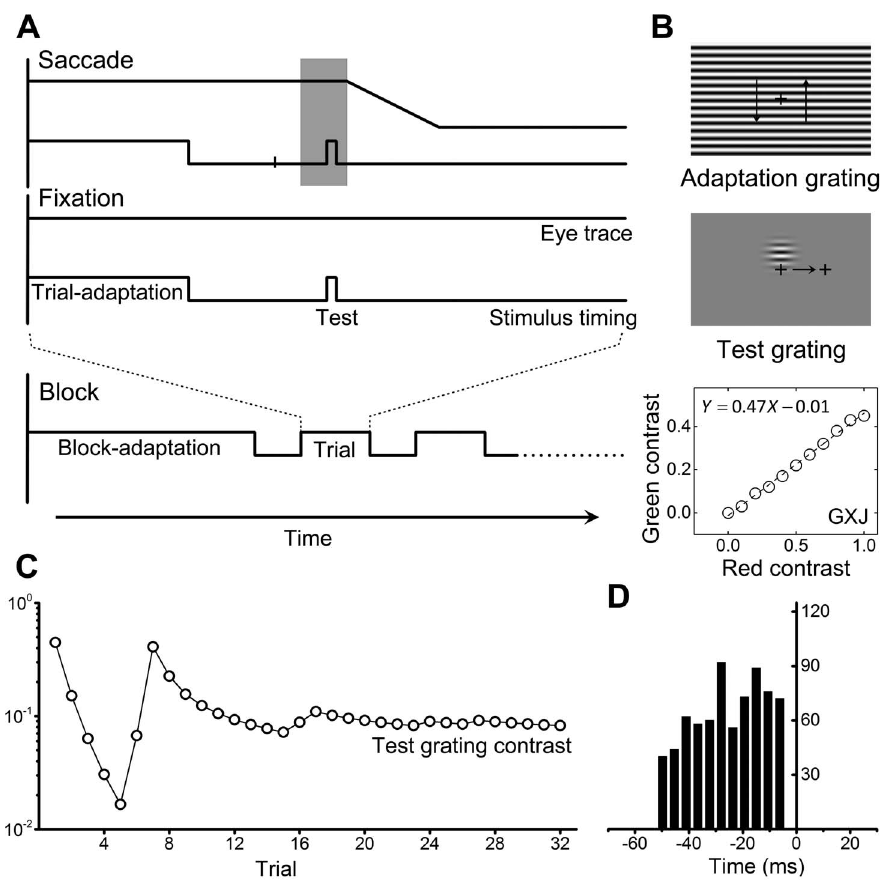
Figure 1. Methods. (A) Schematic illustration of block and trial designs. In saccade trials, the short vertical bar on stimulus timing represents the onset of saccade target, followed by a time interval (gray band) when test grating was presented. In fixation trials, test grating was presented after a comparable interval after adaptation as that of saccade trials. Events are not sequenced with real time scale. (B) Adaptation grating (upper panel) and test grating (middle panel) were used under saccade and fixation (only stimuli of achromatic condition were shown in the figure). The arrows in adaptation grating show the direction of motion, while the arrow in test grating shows the direction of saccade. The lower panel is the equiluminance data of one observer (GXJ) derived from flicker photometry. Dash line denotes the linear fit of the data. Thus the amplitude ratio between green and red channel for this observer is 0.47. (C) Contrast of test grating converges in 32 trials of a single task under the control of QUEST algorithm and a 75% correct threshold is then suggested. (D) Distribution of the time of test grating presentation prior to saccade onset, collected from all participants. Data used here actually ranged from 2 51 to 2 5 ms because offline analysis of eye movements uses slightly different saccade velocity criteria from that of online parser. Experiment details are fully described in section Methods.